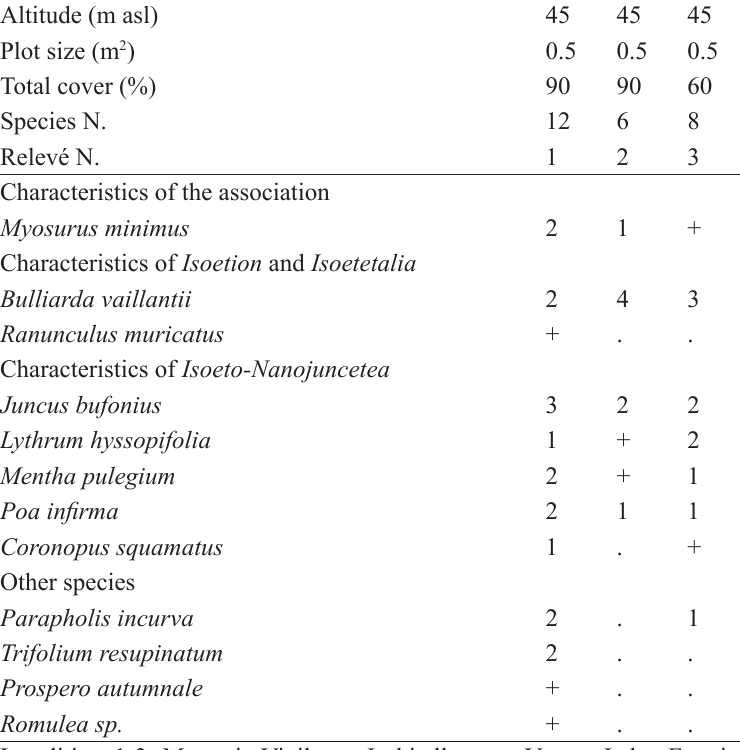
Table 1. Myosuro minimi-Bulliardetum vaillantii Br.-Bl. 1936 ( Isoetion , Isoetalia , Isoeto - Nanojuncetea ) Altitude (m